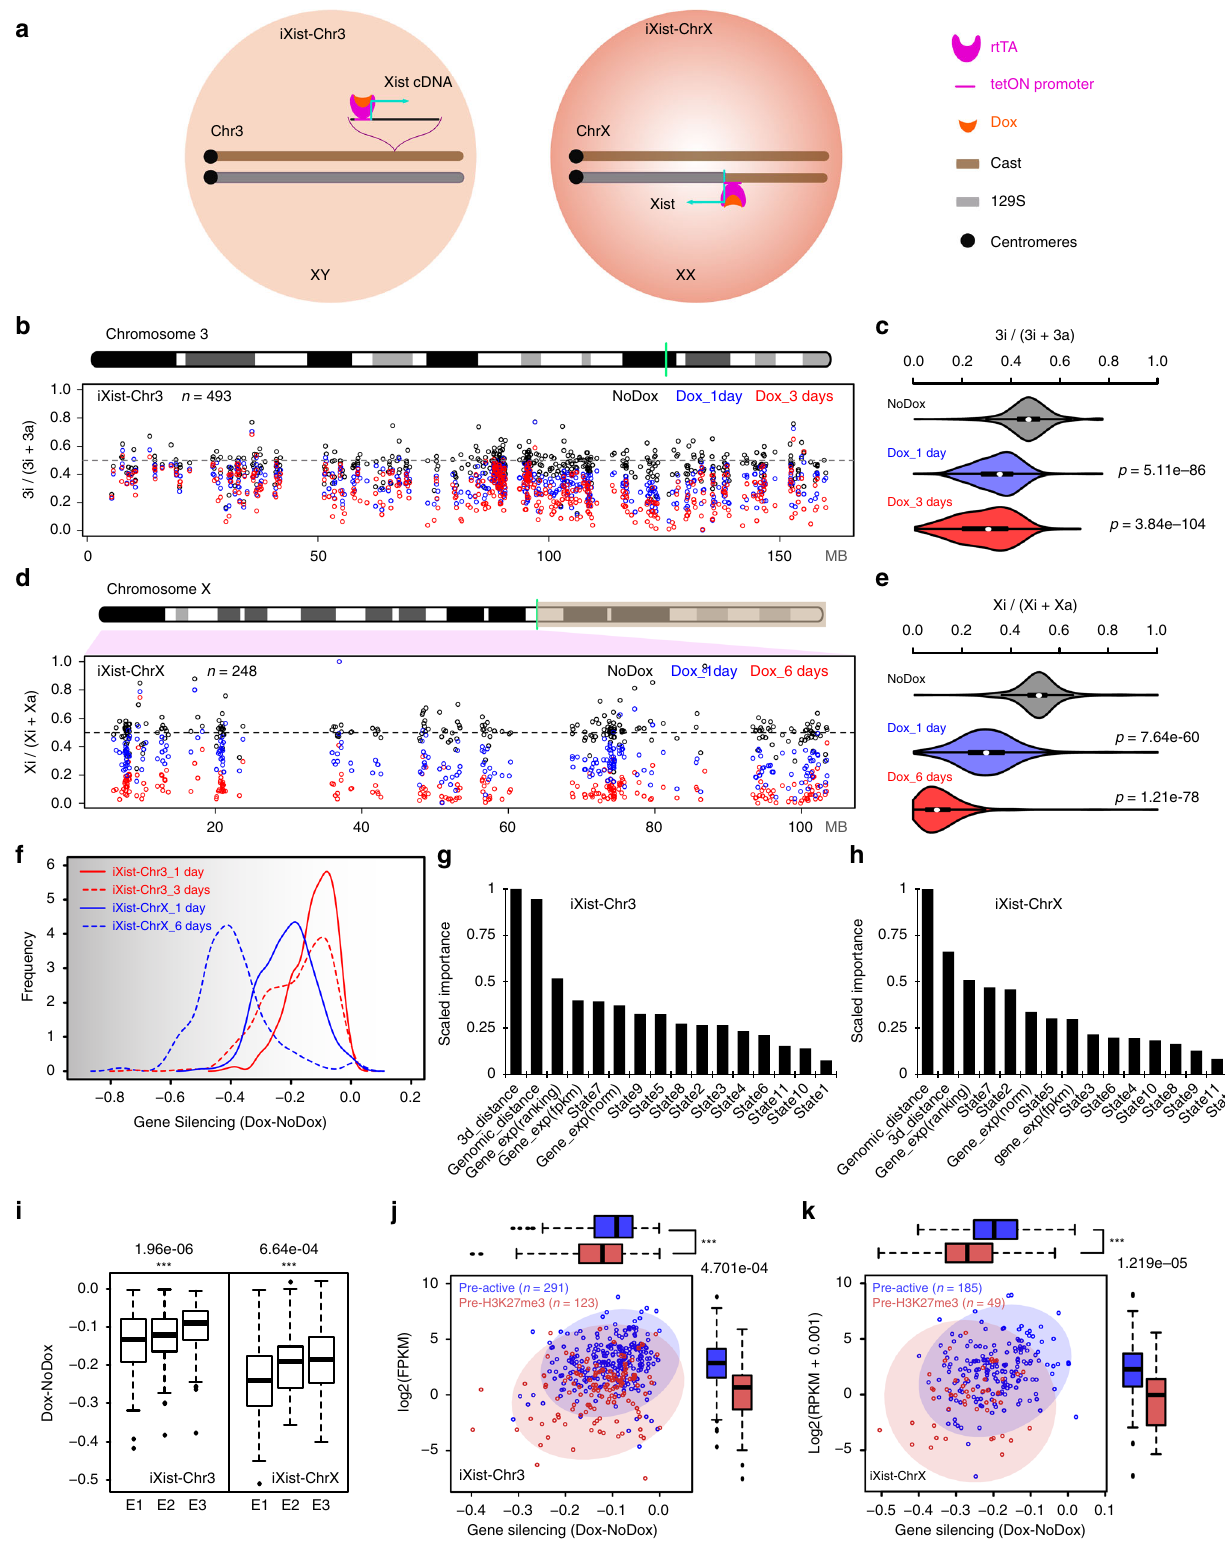
correlation for iXist-Chr3 cells using, as a surrogate marker, Polycomb-mediated histone modi fi cations, H2AK119ub and H3K27me3, determined using allelic calibrated ChIP-seq (Sup- plementary Fig. 1f). Using a published cohesin HiChIP dataset 34 , we found a close correlation ( r = 0.76 – 0.77) between Xist-